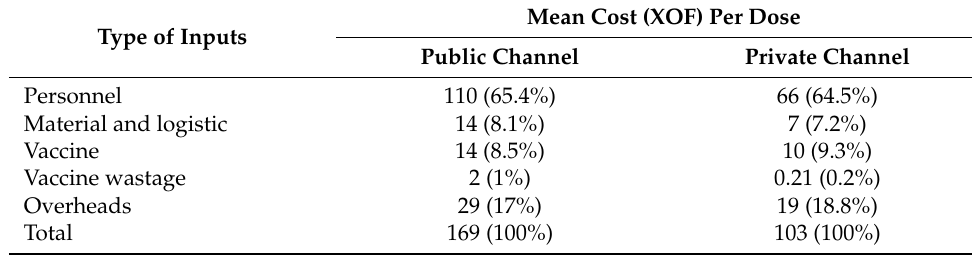
Table 2. PPR vaccination cost by inputs.